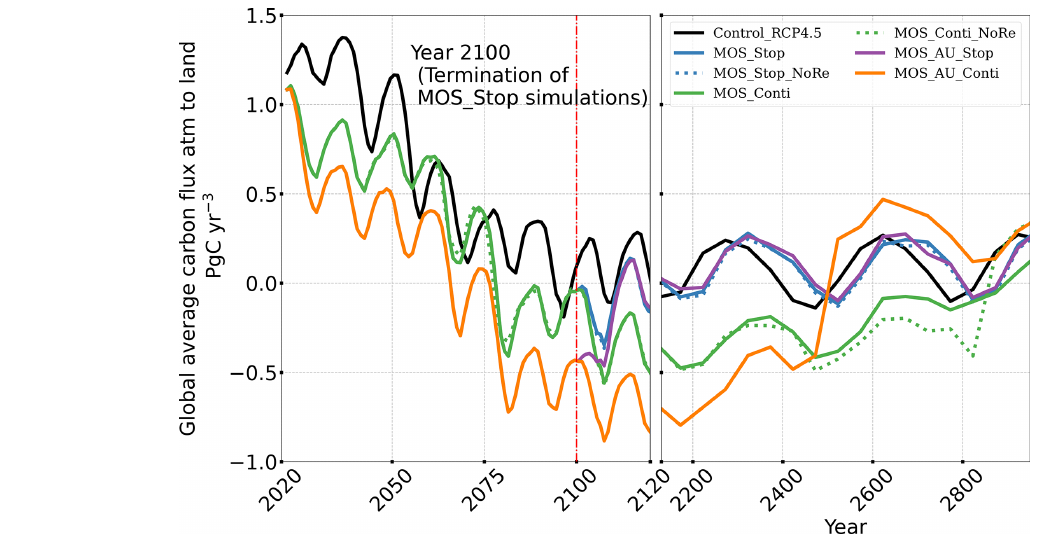
Figure B10. Global averaged carbon flux from atmosphere to land.